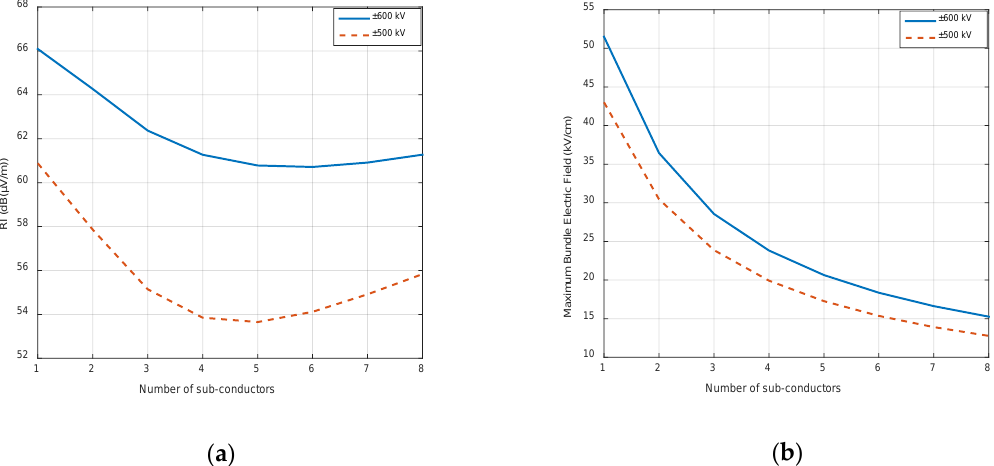
Figure 6. Parametric sweeps: ( a ) RI as a function of bundle spacing; ( b ) Maximum bundle electric field ( g max ) as a function of bundle spacing.